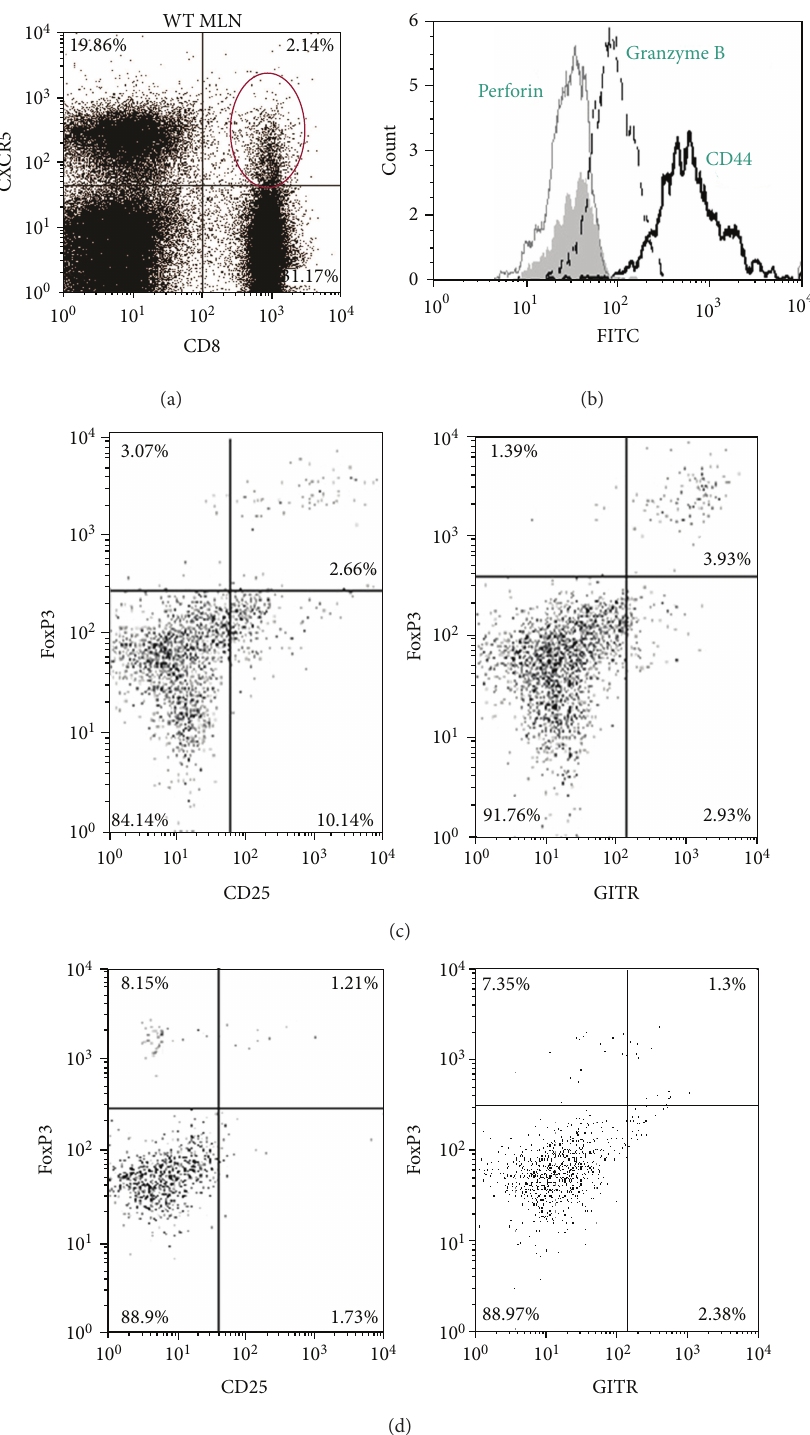
cells express the phenotype of Tregs. MLNs were isolated from C57BL/6 WT mice 7 days aer genital infection with C. muridarum and stained with CD3, CD8, CXCR5, and various markers of cytotoxic and regulatory T cells. (a) e dotplot shows + cells. (b) Histogram of CD3 CD8 CXCR5 cells showing the individual expression of perforin the percentage of CD8 and CXCR5 on CD3 (gray line), granzyme B (dash line), and CD44 (black line). Irrelevant control antibody stained cells appear as a shaded histogram. (c) Dotplot + + + + CD8 CXCR5 cells expressing of FoxP3 and CD25 or FoxP3 and GITR following stimulation of spleen cells showing the percent of CD3 CD8 cells expressing of FoxP3 from mice during genital infection with C. muridarum . (d) Dotplot showing the percent of CD3 + + + and CD25 or FoxP3 and GITR following stimulation of spleen cells from naive +